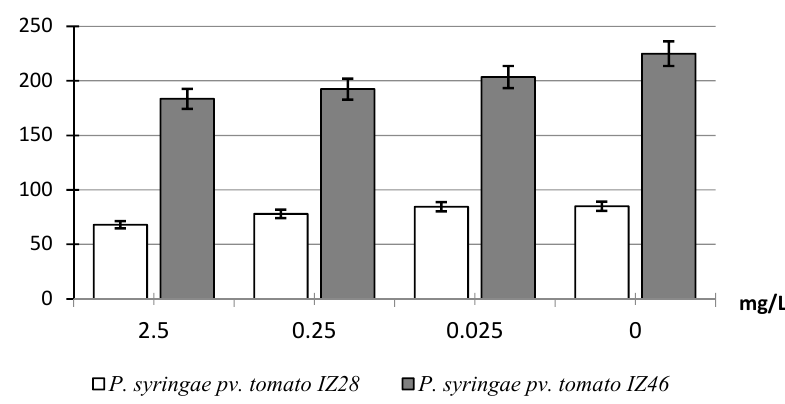
Figure 2. E ff ect of deltamethrin on the growth of P. syringae pv. tomato: Figure 2. Effect of deltamethrin on the growth of P. syringae pv. tomato: “0” — control.